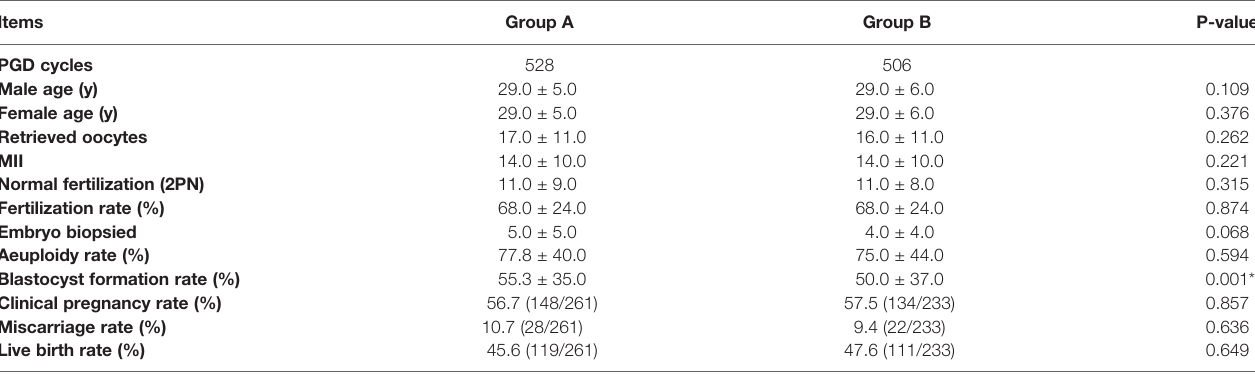
TABLE 1 | Comparison of overall conditions between male and female carriers.